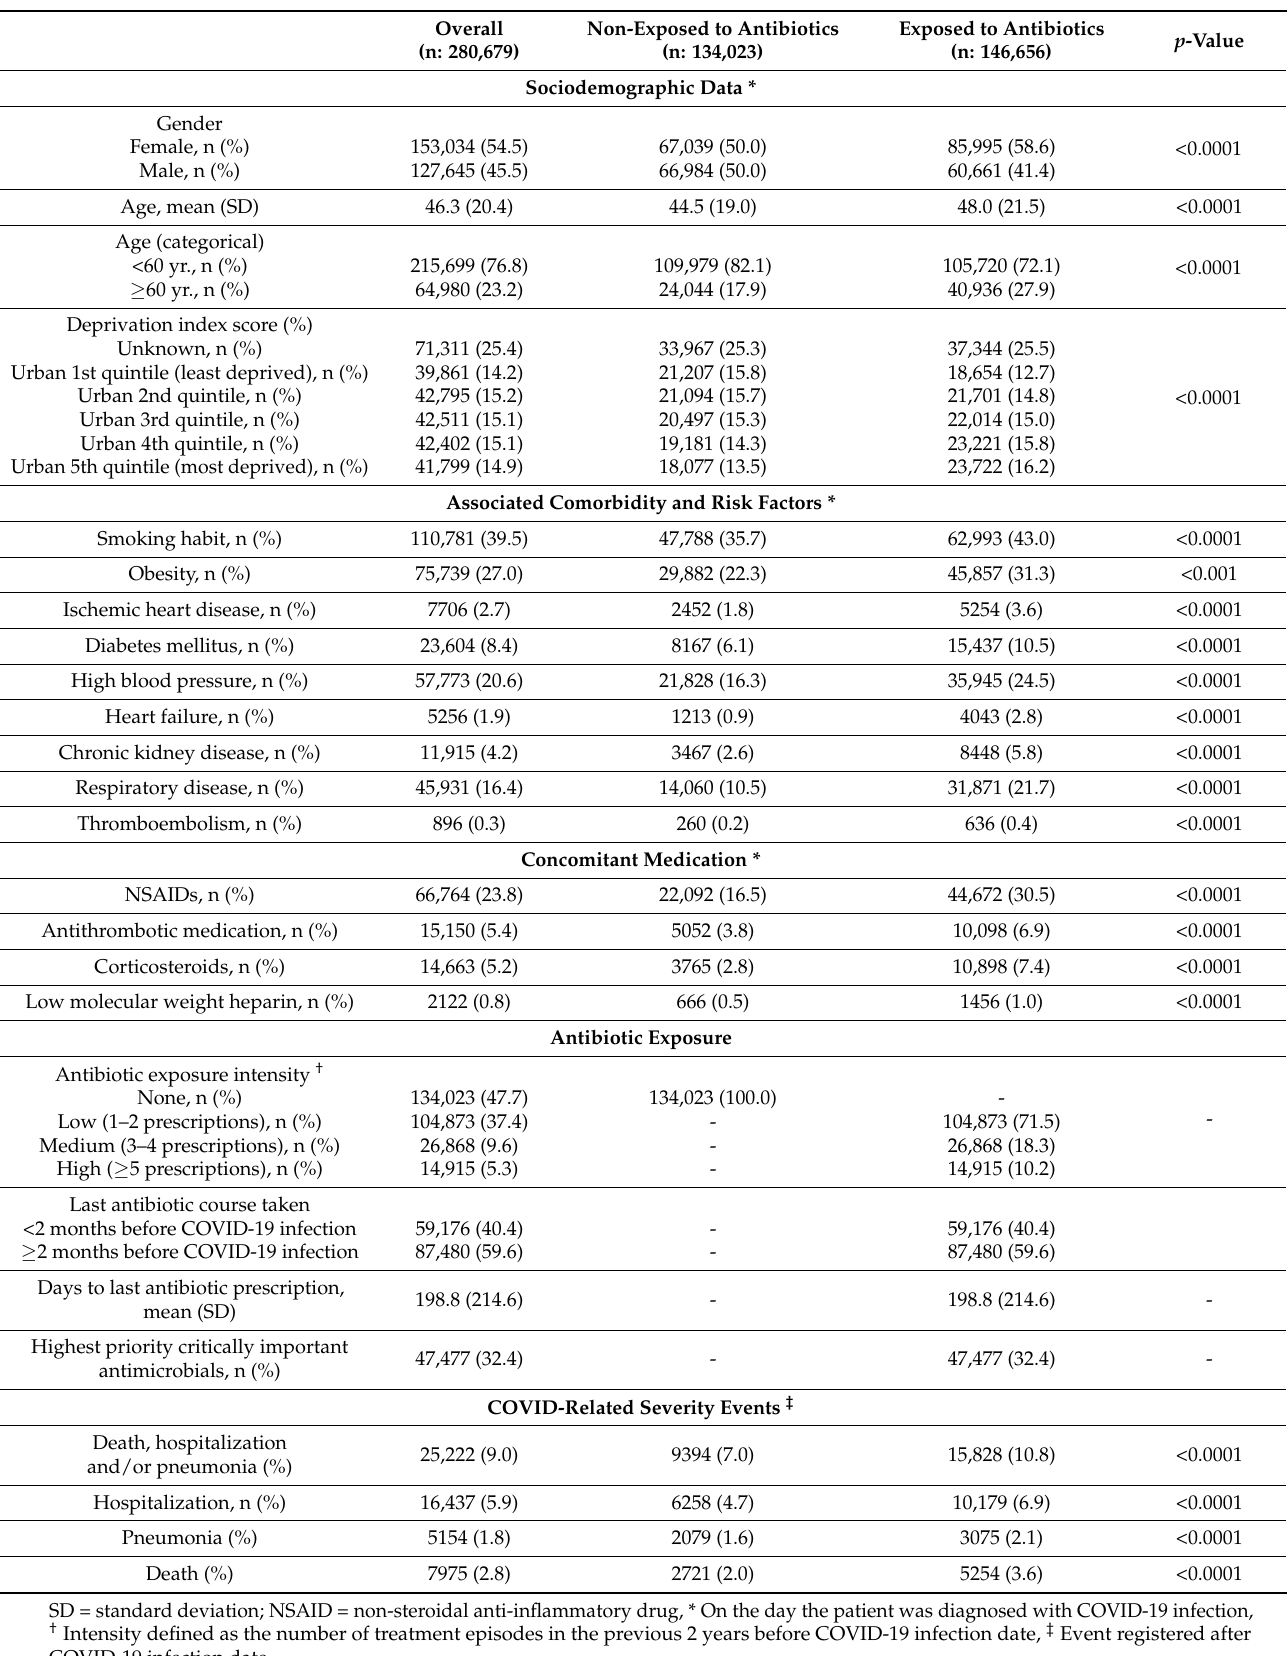
Table 1. Distribution of patients with COVID-19 by exposure to antibiotics in the previous two years.